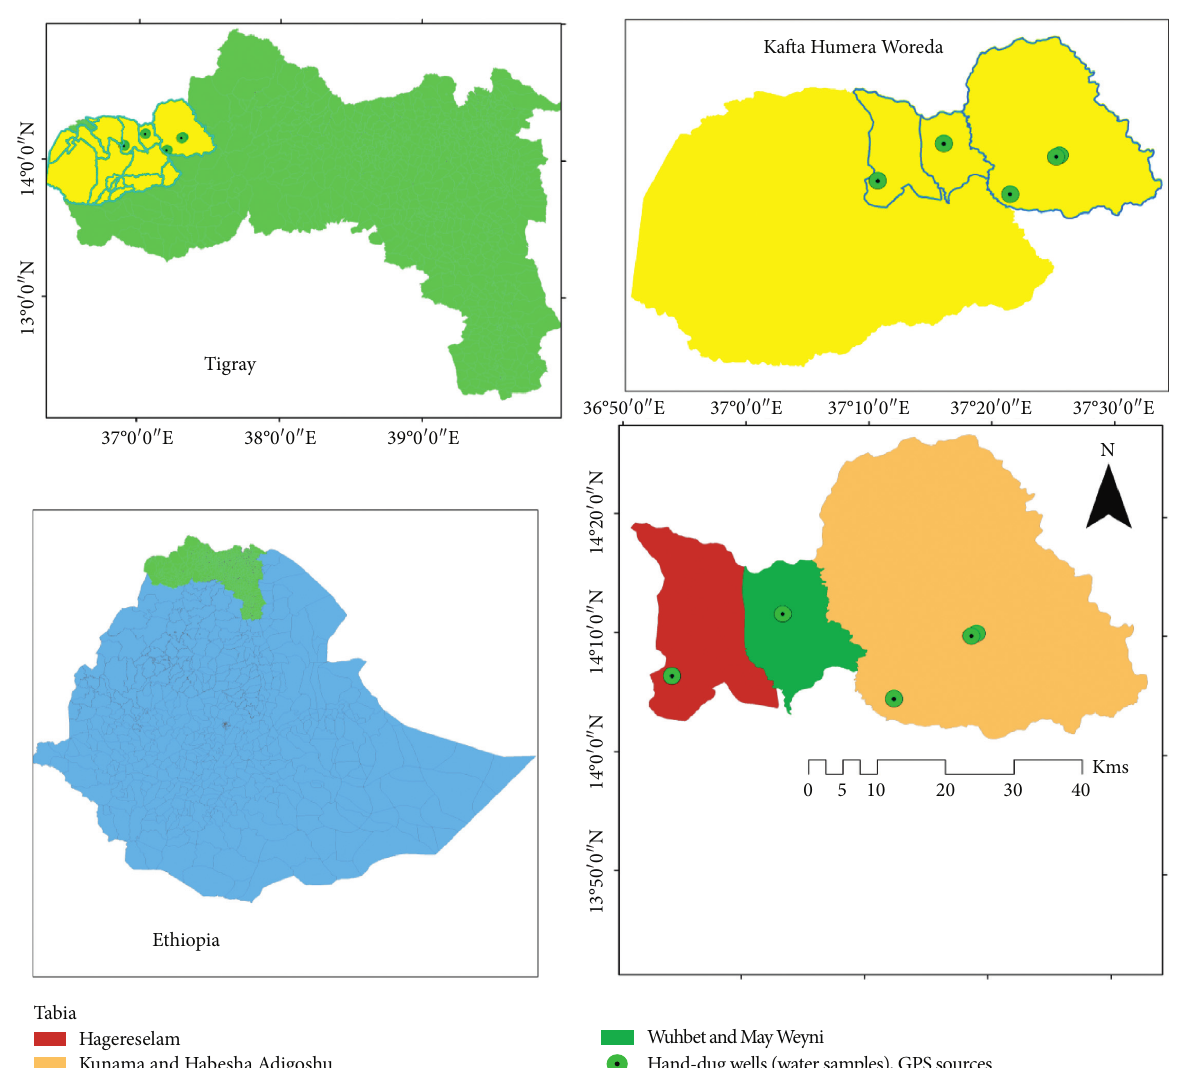
Figure 1: Map of the study